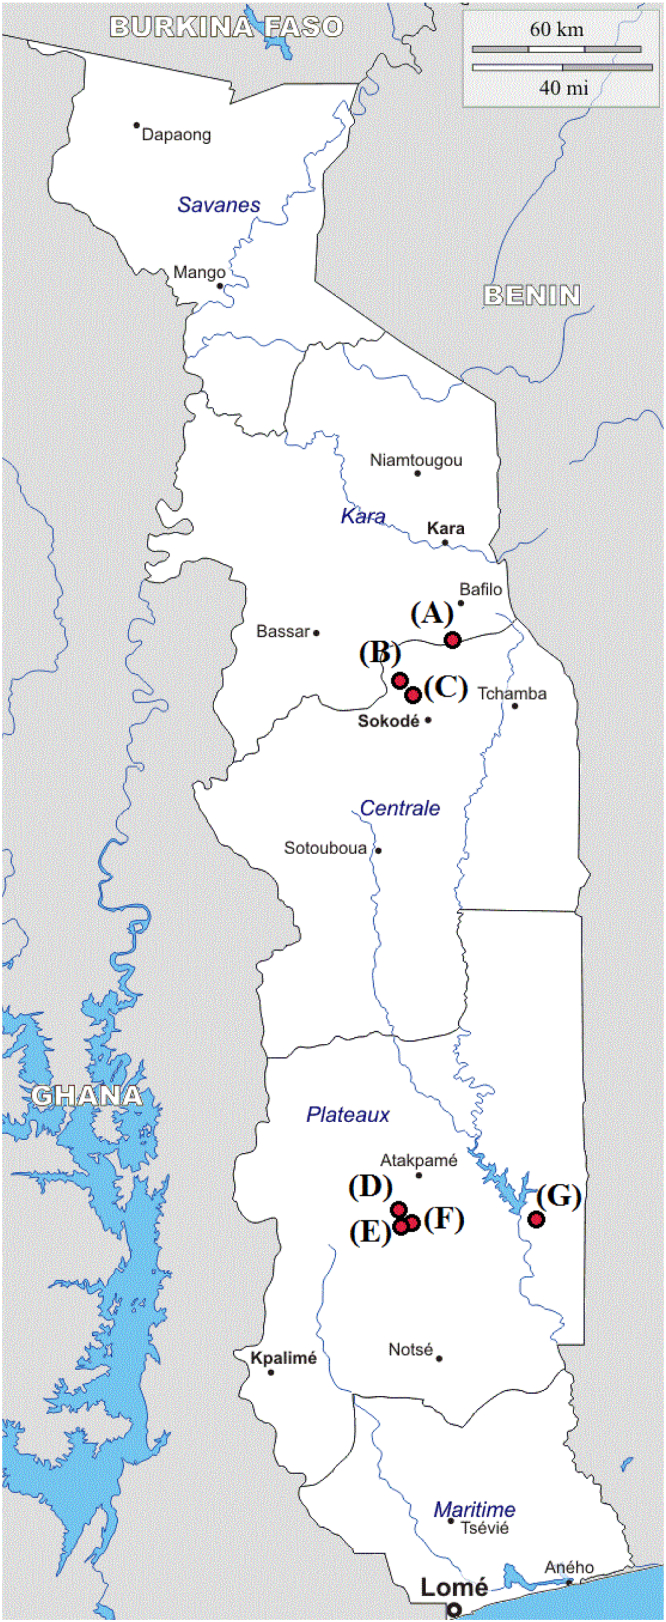
Map showing the locations of the surveyed villages Kéméni (A), Bouzalo (B) and Sagbadai (C) in the Région Central, and the villages Tsokple (D), Kpati Cope (E), Igbowou-Amou (F) and Atinkpasse (E) in the Région Plateaux in Togo. The regions were included into the vector control activities of the Onchocerciasis Control Program (OCP) in 1987 and in both regions, black fly vector control measures were supplemented in 1989 by mass drug administration (MDA) with ivermectin.